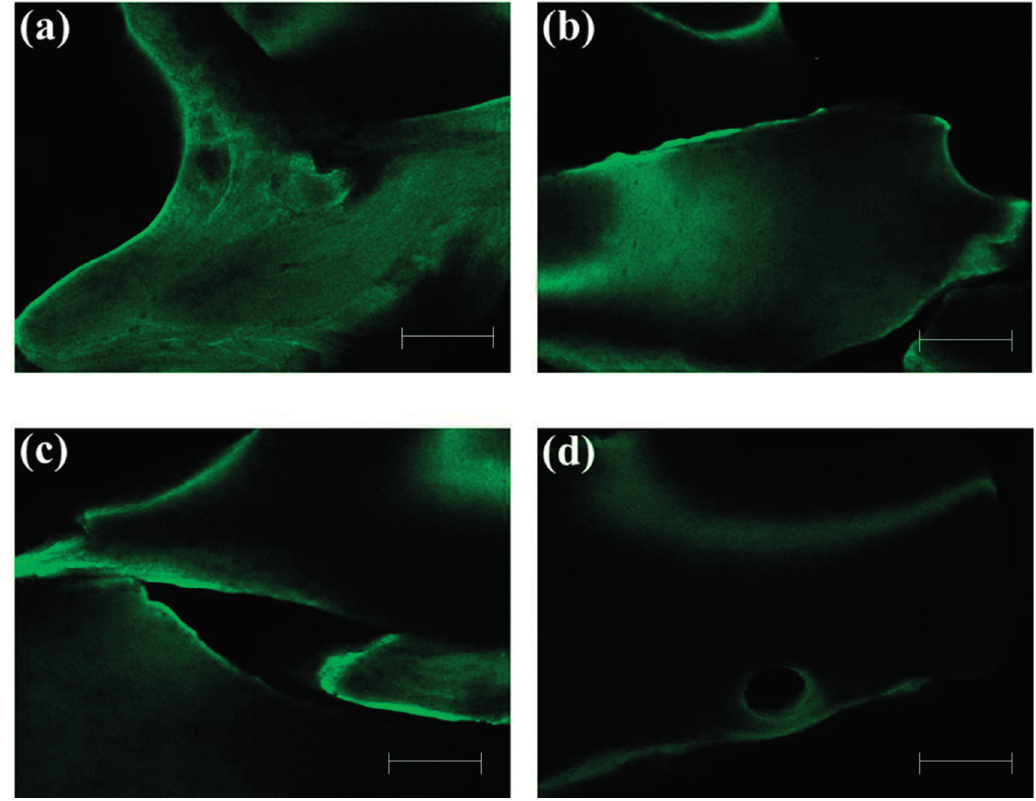
Figure 2. Confocal laser scanning microscopy (CLSM) images of GFP-conjugated rhBMP-2-Bio-Oss ® surfaces for ( a ) 1 day; ( b ) 3 days; ( c ) 7 days; and ( d ) 10 days in 0.1 M MES buffer. Scale Bars: 0.5